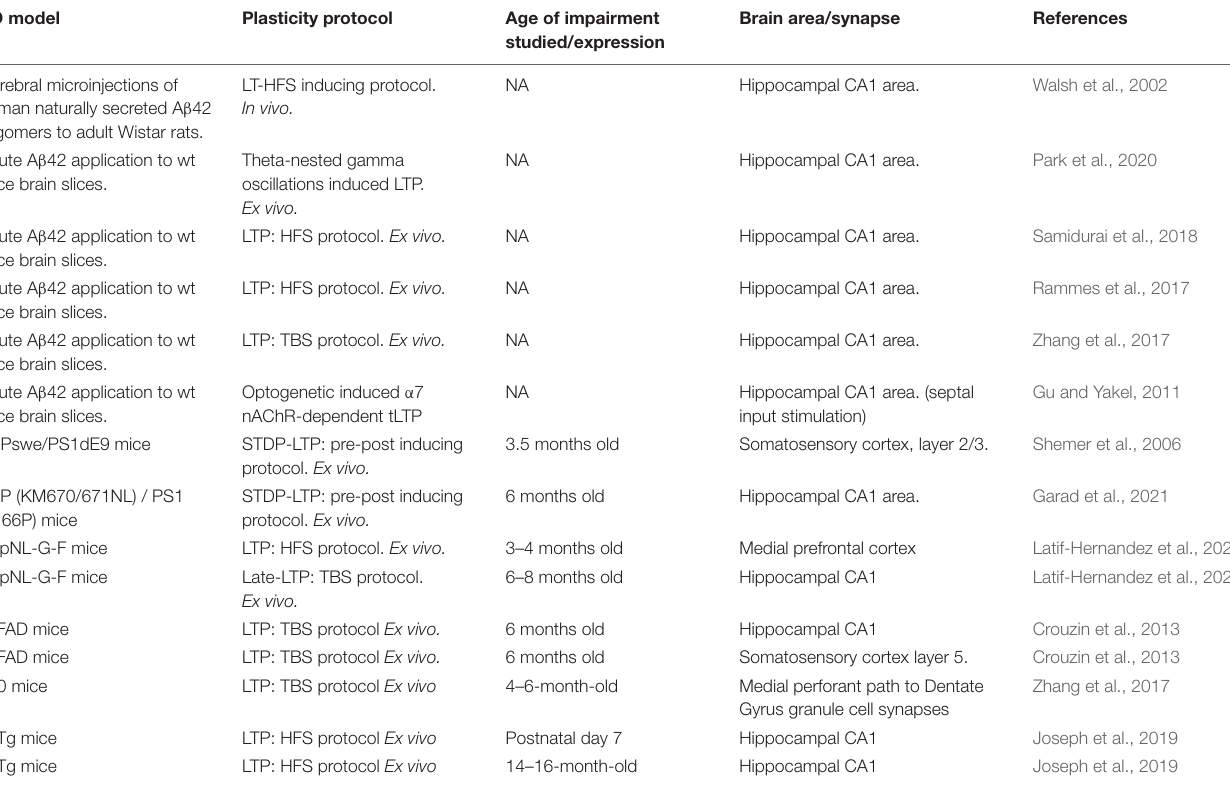
TABLE 1 | Summary of studies on LTP in AD-related models showing the diversity of approaches and the studied time point during AD progression. AD